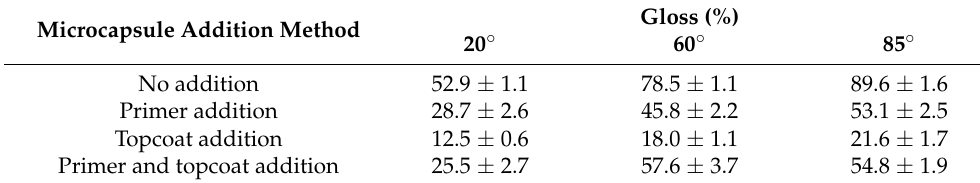
Table 6. Influence of adding methods on the gloss of the paint film.